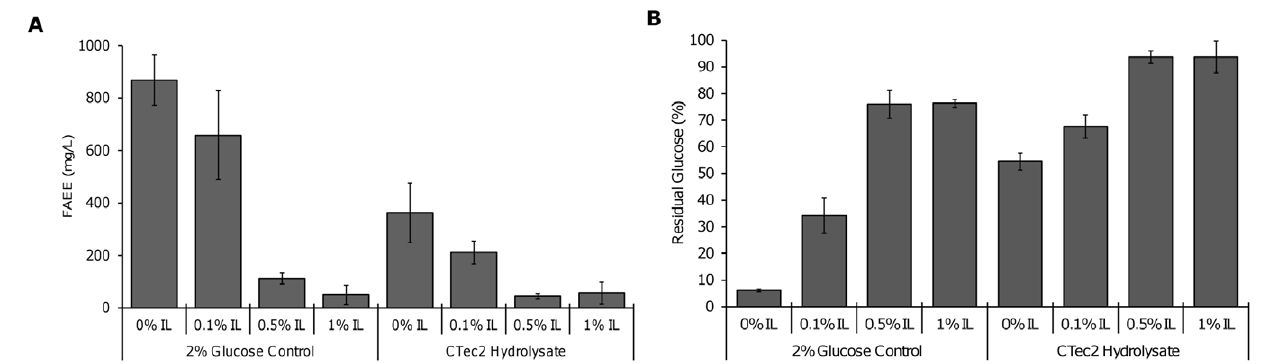
Figure 6. Effects of ionic liquids on biodiesel production by an engineered E.coli strain. The strain was fed either 2% glucose or a CTec2 hydrolysate of IL- pretreated switchgrass containing 0–1% (w/v) [C2mim][OAc] [(A). The percentage of glucose remaining after fermentation was measured (B). Glucose levels were adjusted to 2% for all hydrolysates and controls. The CTec2 control contained equivalent amounts of purified glucose and xylose as the hydrolysate. No xylose was consumed during the fermentation (data not shown). Error bars indicate the standard deviation of triplicate experiments.